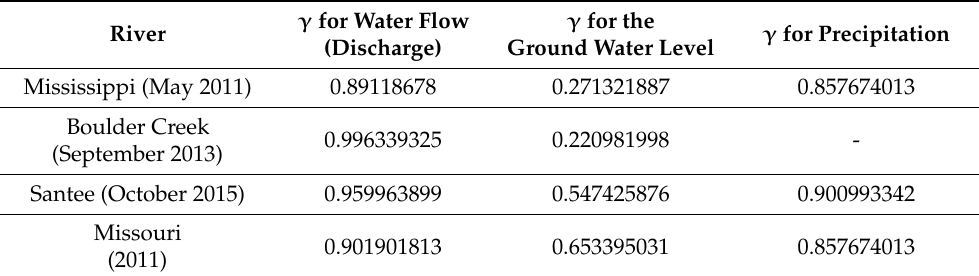
Figure 14. The results of mathematical modeling for flood forecasting based on statistical data for the entire research period (i–number of months): ( a ) for the Mississippi river; ( b ) for the Santee river; ( c ) for the Missouri river; ( d ) more detailed scale fragment for the Santee river (see text above the figures). Here, Q–real water flow (feet/s) (red) and predicted dependence (blue). Table 2. Calculation results of the visibility coefficient γ (showing the process of correlation in time for the units) based on the data for water consumption/discharge, ground water level, and the amount of precipitation in the study